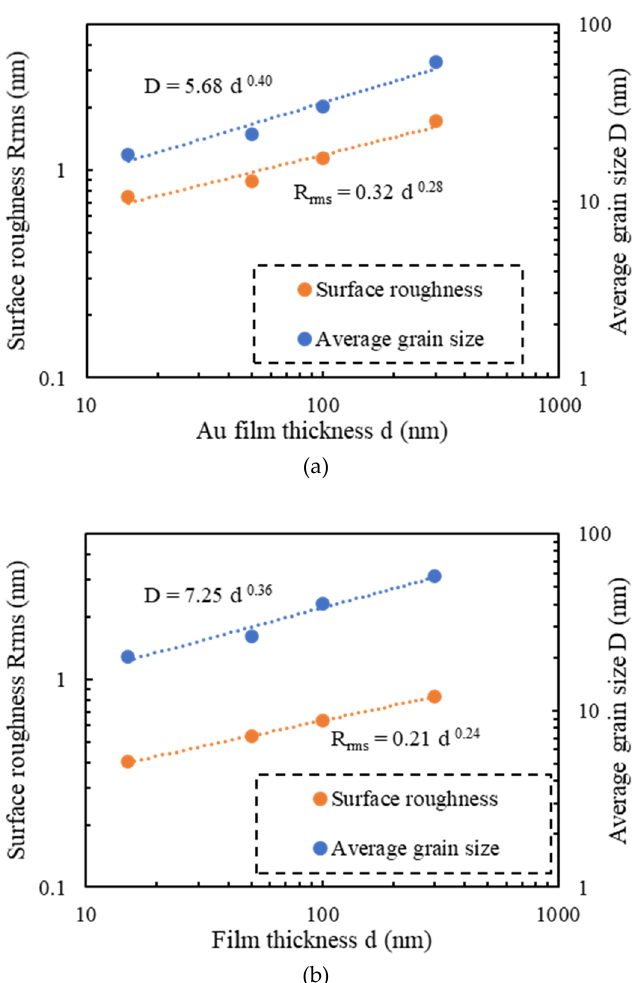
Figure 13. Effect of Au film thickness on surface roughness and average grain size: ( a ) films deposited on Si wafers with cavities; ( b ) films deposited on glass wafers.